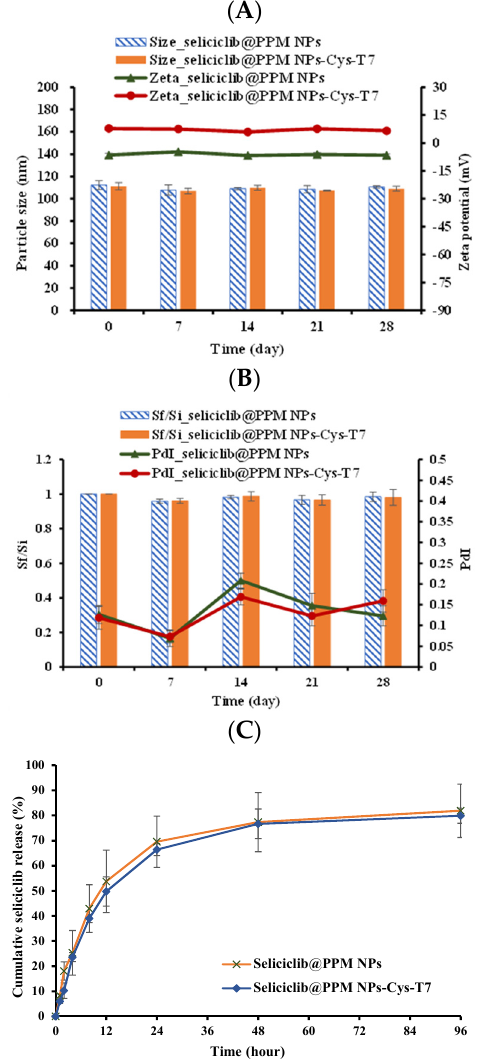
Figure 3. Stability of lyophilized seliciclib@NPs for 28 days. ( A ) Particle sizes (bar) and zeta potentials (line). ( B ) Final to initial size ratio (S f /S i ) (bar) and PdIs (line). ( C ) Cumulative release of seliciclib from seliciclib@NPs in pH 7.4 phosphate-buffered saline (PBS) release medium at 37 °C. (n = 3, mean ± SD).